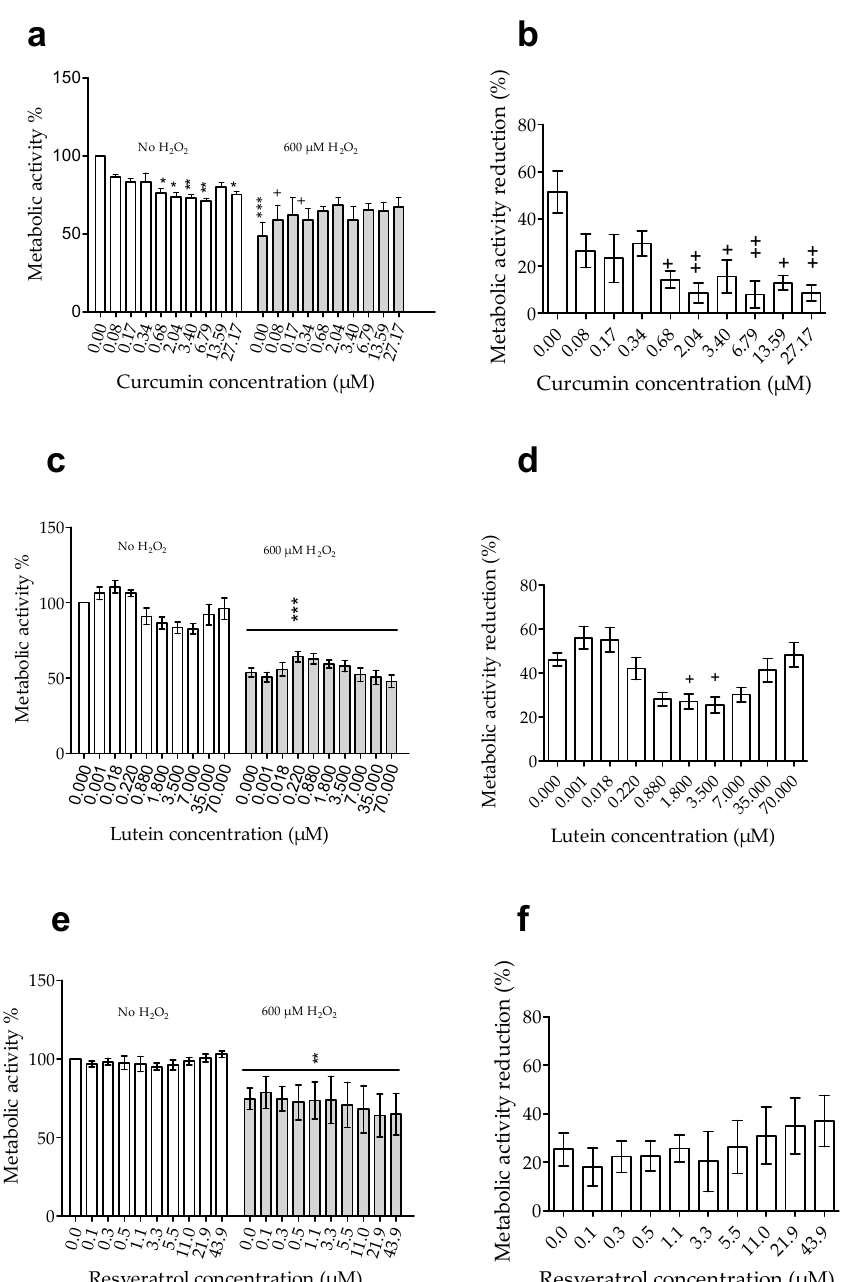
Figure 2. E ff ect of curcumin, lutein, and resveratrol on oxidative stress induced by H 2 O 2 . ARPE-19 cells were untreated (0) or pre-treated with di ff erent concentrations of curcumin ( a,b ), lutein ( c,d ), or resveratrol ( e,f ) before adding 600 µ M H 2 O 2 or No-H 2 O 2 . Metabolic activity was quantified by MTT assay. Left (a,c,e): Relative metabolic activity with No treatment (0.0)-No H 2 O 2 (left side of the graph) being 100%. Right (b,d,f): Metabolic activity reduction corresponding to metabolic activity of cells with No-H 2 O 2 minus the one of cells with 600 µ M H 2 O 2 for each treatment. Results are expressed as mean ± SEM ( n = 4 to 11 for lutein; 3 to 5 for curcumin and 3-4 for resveratrol, where each test was performed in triplicates). (*) compared to no treatment-No H 2 O 2, ( + ) compared to No treatment-600 µ M H 2 O 2.